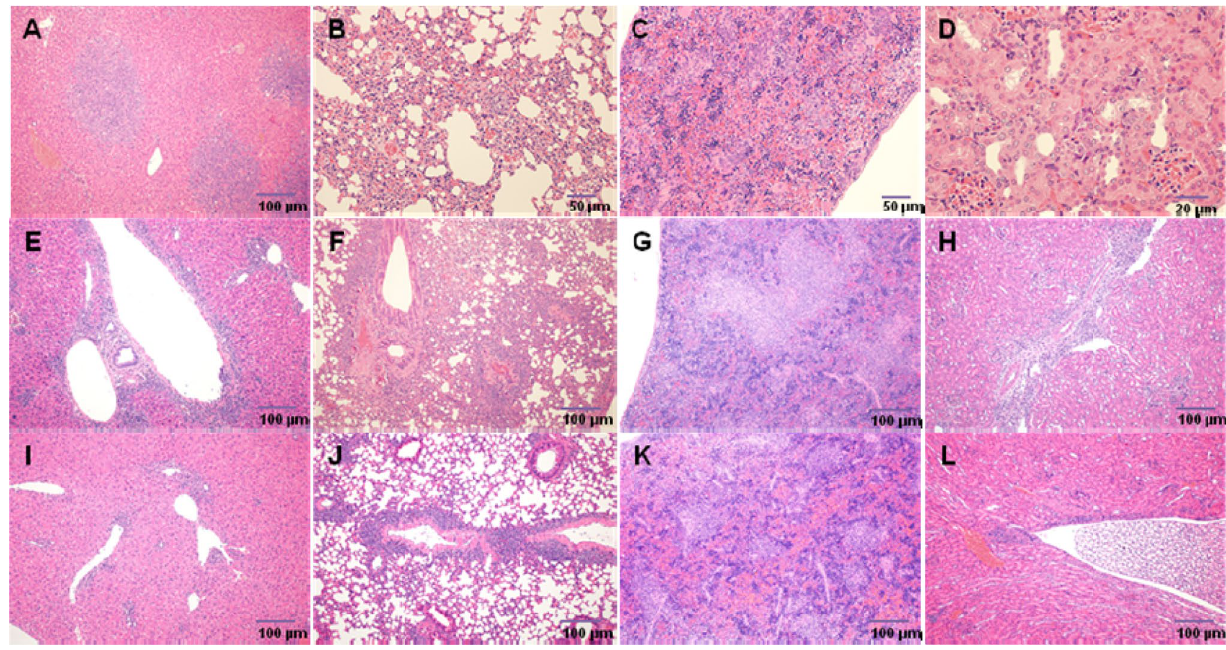
Fig.7 Histopathological changes of CAR-T20 in tumor-bearing animals (HE staining). A Buffer group, liver, lymphoma (100 ×); B Buffer group, lungs, lymphoma (200 ×); C Buffer group, spleen, lymphoma (200 ×); D Buffer group, kidney, lymphoma (400 ×); E T cell group, liver, mild mixed cell aggregation, very mild single hepatocyte necrosis, lymphoma (100 ×); F T cell group, lungs, moderate mixed cell aggregates, lym- phoma (100 ×); G T cell group, spleen, mild mixed cell aggregation, lymphoma (100 ×); H T cell group, kidney, mildly mixed cell aggregation (100 ×); I T cell group, liver, mildly mixed cell aggregation (100 ×); J T cell group, lungs, moderate mixed cell aggregates, lymphoma (100 ×); K T cell group, spleen, mildly mixed cell aggregation (100 ×); L T cell group, kidney, very mild mixed cell aggregation (100